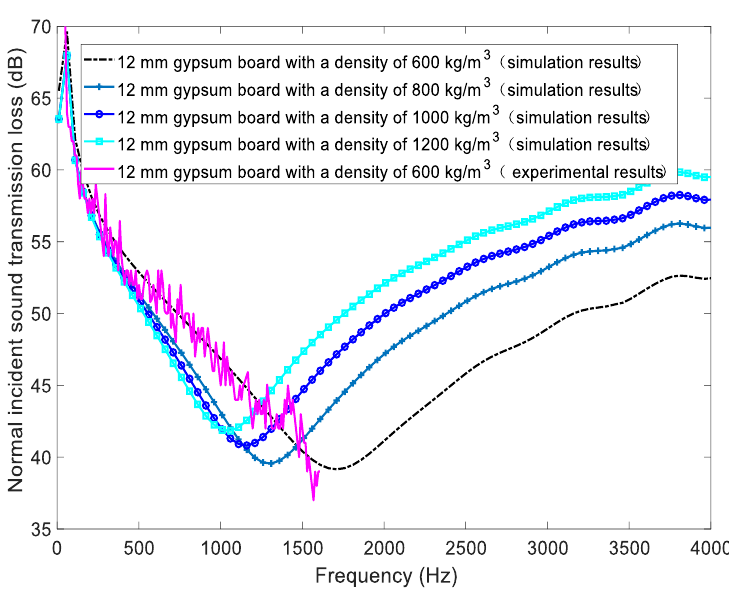
Figure 7. The STL spectrum of the composite partitions with the change of gypsum board’s density.